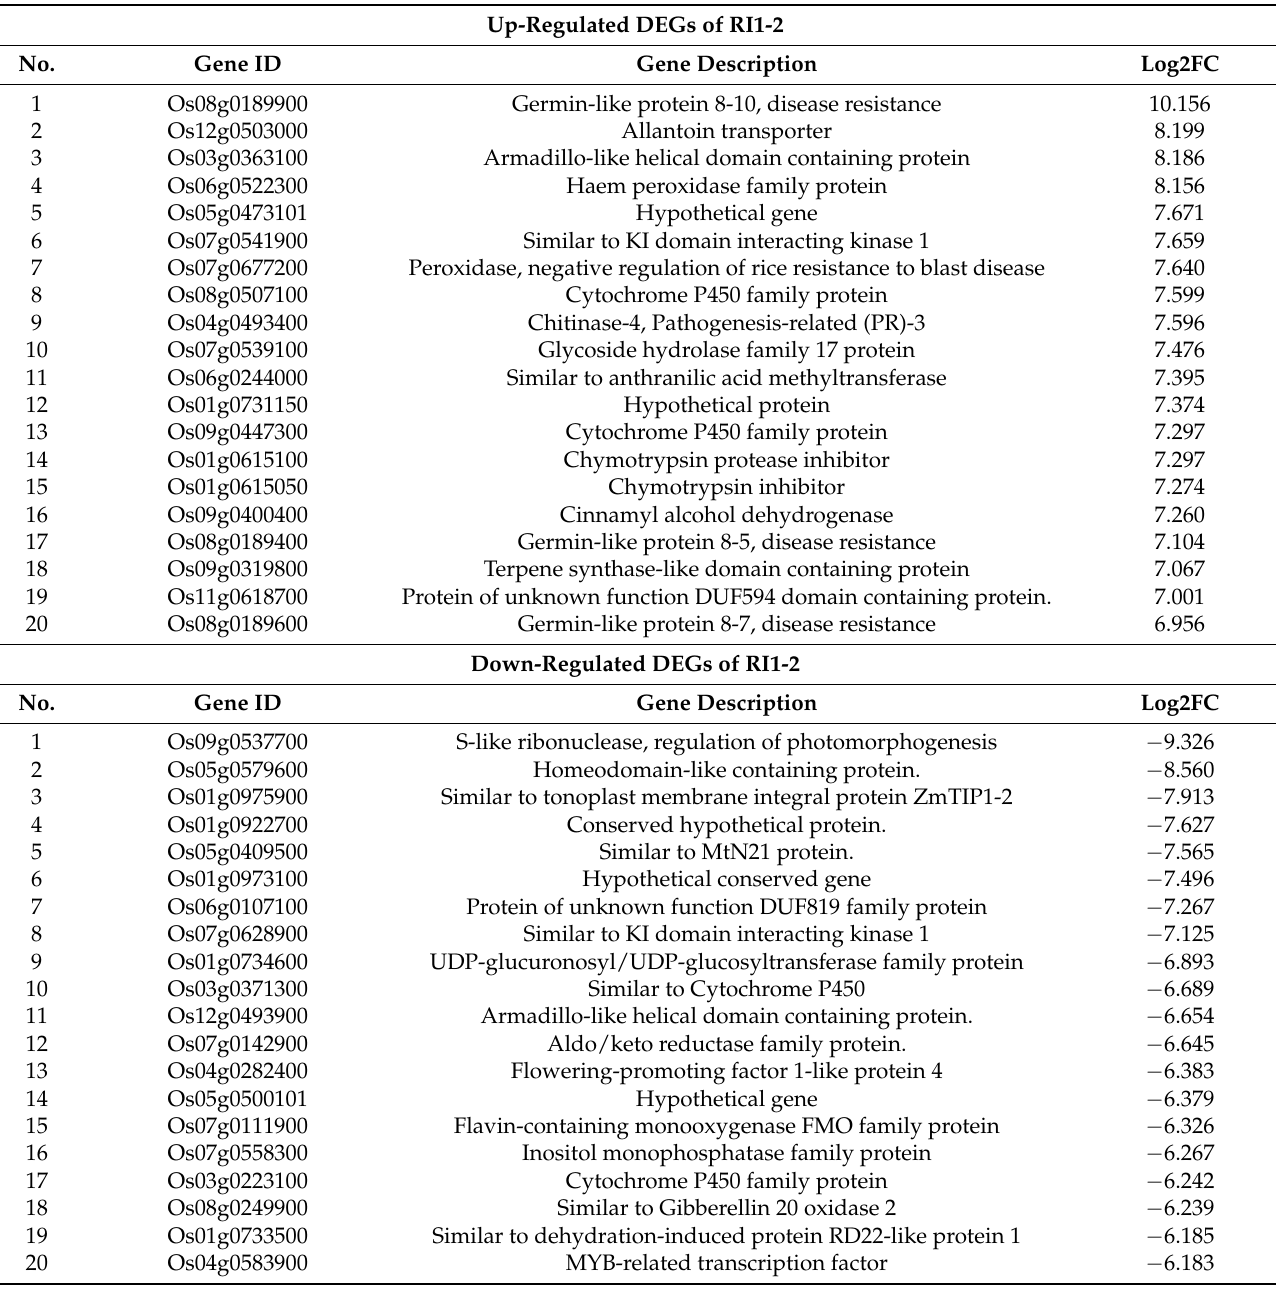
Table 1. Top 20 up- and down-regulated differentially expressed genes (DEGs) in OsVTC1-1 RI1-2 line at 24 h after inoculation with rice blast 10100 isolate. Genes were ranked by log2FC